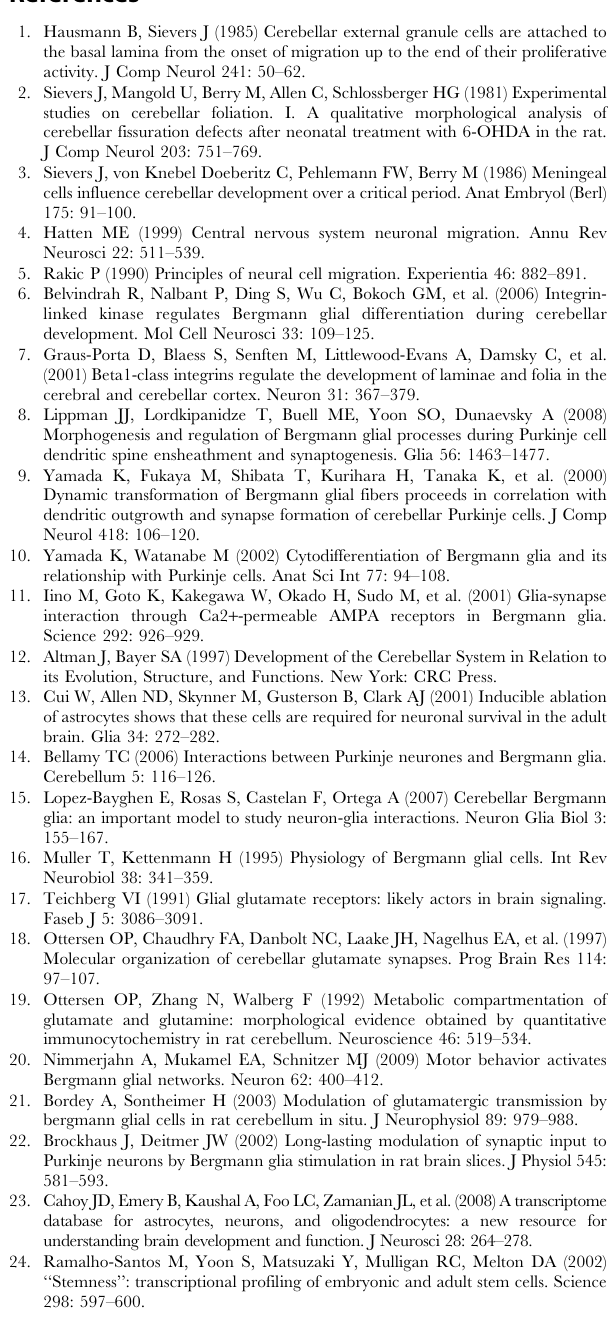
(for example, as in Fig. S2) can be compared. Scale bar, 500 m m in all panels, 140 m m in